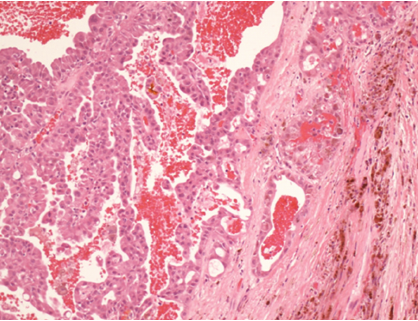
Figure2:Themicroscopicexaminationshowscysticcharacteristics.